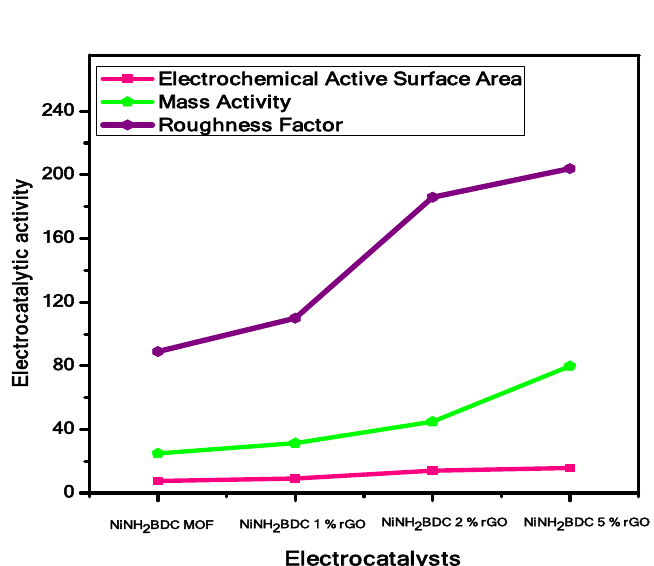
Figure 14. The comparison of EASA, Mass activity, and Roughness factor of NiNH 2 BDC MOF/1, 2, 5 wt% reduced graphitic carbon hybrids.